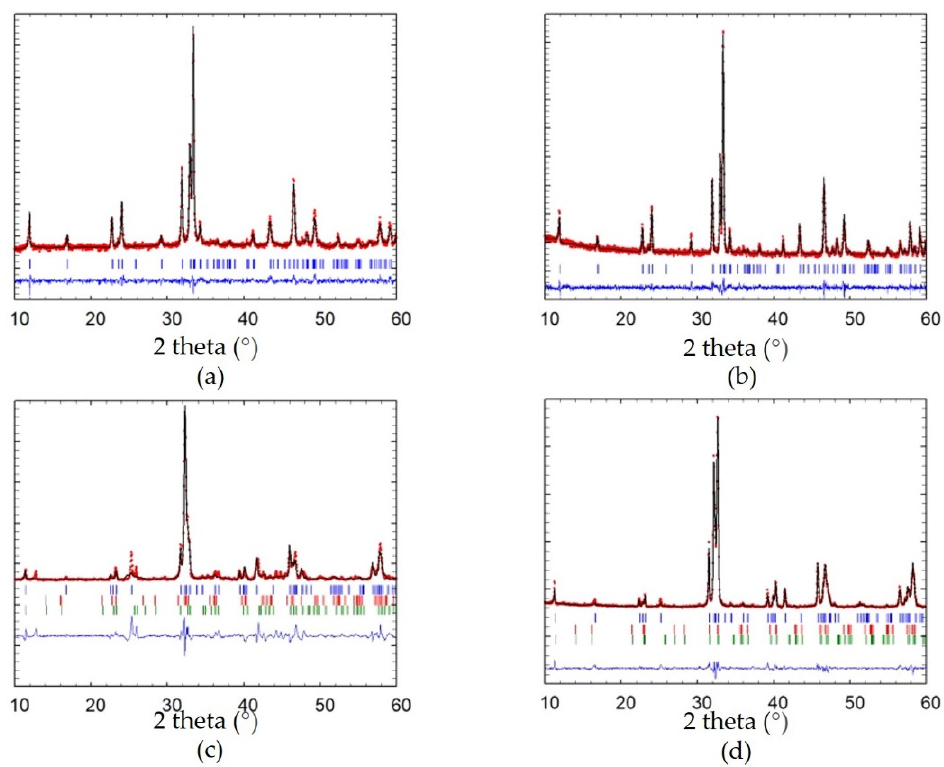
Figure 1. XRD pattern and Rietveld refinement of ( a ) CFO_cp, ( b ) CFO_eaf and ( c ) SFO_cp, ( d ) SFO_eaf. Red curves: measured data, black curve: Rietveld refinement, blue line: difference. Vertical bars indicate the Bragg peak position: the blue ones correspond to the main phase CaFeO 2.5 (in a,b), SrFeO 2.5 (in c,d), while the red and green ones in (c) and (d) correspond to SrFeO 2.75 and SrFeO 2.87 , respectively). Table 1. Refinement data and phase composition obtained from Rietveld refinement for